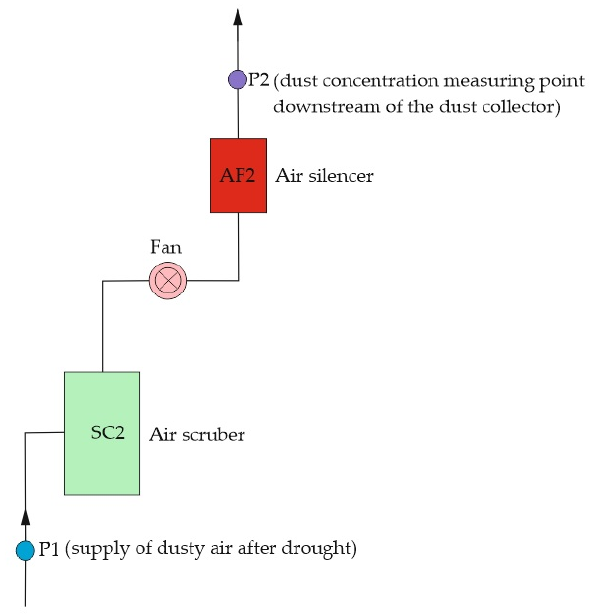
Figure 2. Scheme of distribution of measuring points in the saltwork of the “Wieliczka” salt mine.